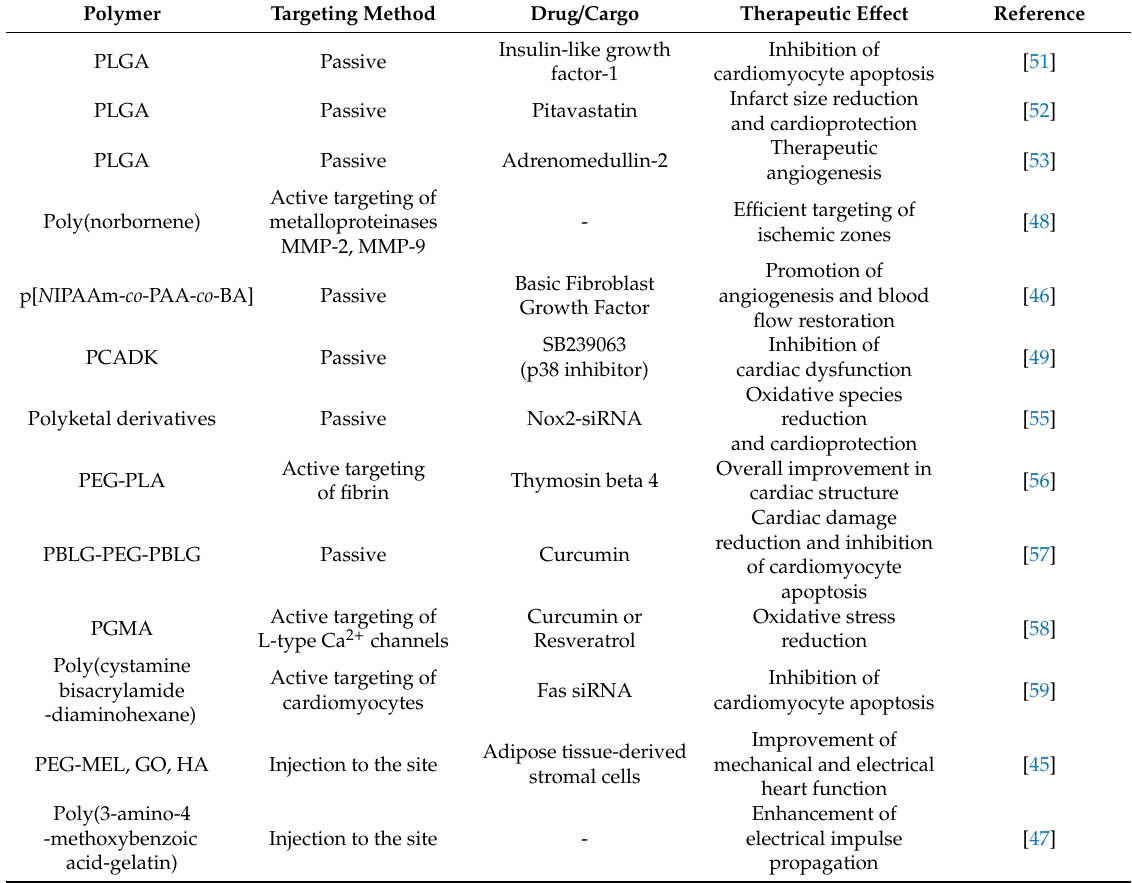
Figure 3. Synthesis and structure of PAMB hydrogel and mechanism of its restoring electrical impulse propagation and synchronizing myocardial contraction following a myocardial infarction. Reproduced with permission from [47], Elsevier, 2019. Table 2. Summary of polymeric nanoparticles and their therapeutic effects.